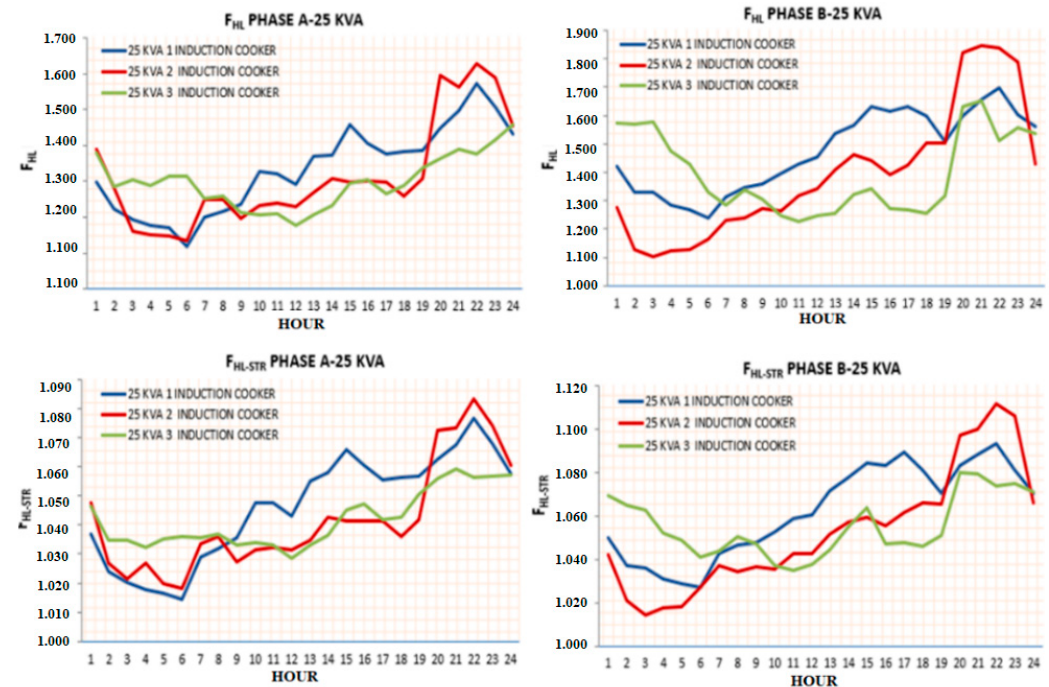
Figure5. Typicalvaluesof F HL andF HL-STR factorsfordi ff erentnumberofinductioncookers, phasesA,B. Figure 5. Typical values of F HL and F HL-STR factors for different number of induction cookers, phases A, B.